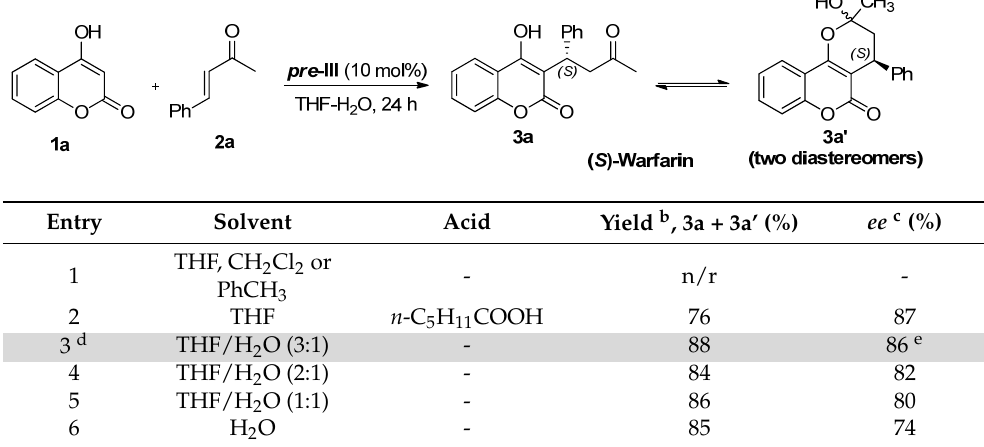
Table 1. Optimization of the reaction conditions a .